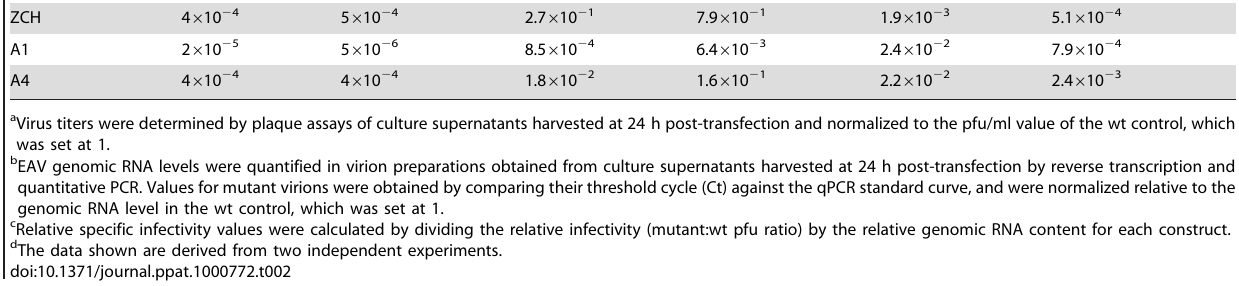
Construct Relative infectivity a Relative genomic RNA content